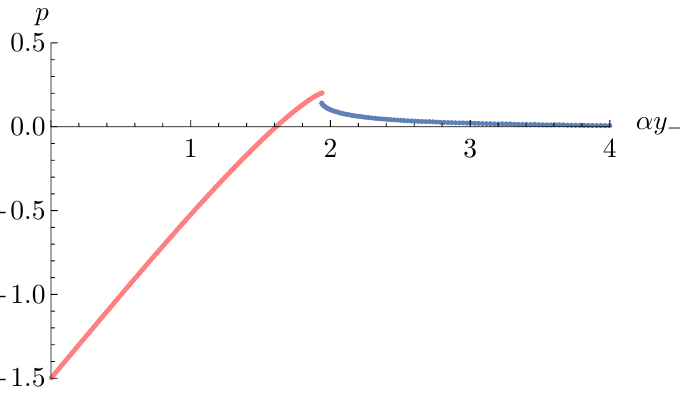
Figure 8. The vev p as defined by (E.1) in the IR finite scheme ( b 3 , b 1 ) = (0 , 0)